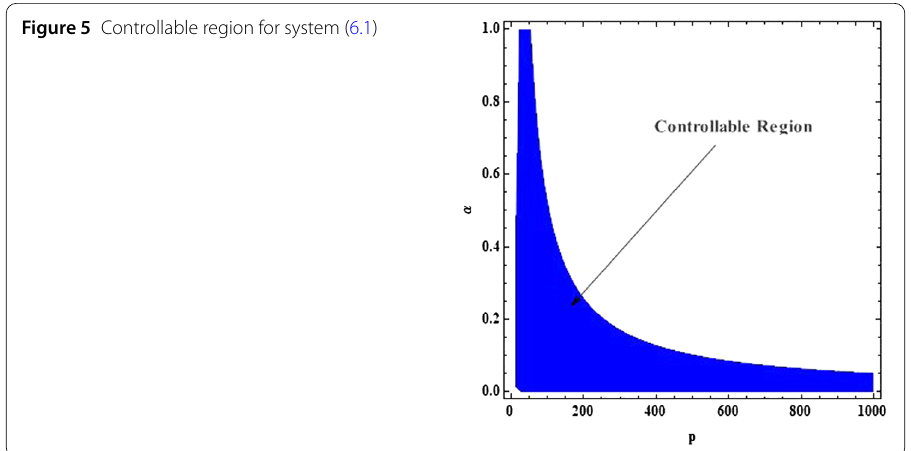
Figure 5 Controllable region for system